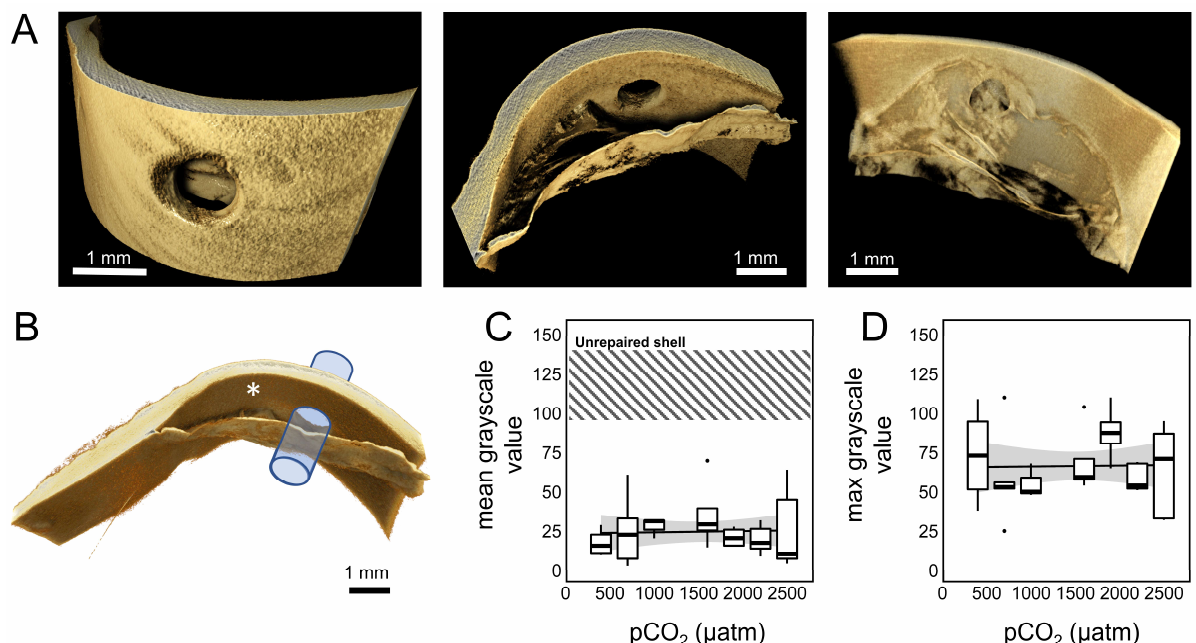
Figure 8. ( A ) The 3D rendering of a drill hole and deposited shell material constructed from µCT scan slices. Images represent three perspectives of the same shell repair from a single mussel ( M. trossulus ) held within the 400 µatm p CO 2 for 10 weeks. ( B ) Cylindrical volume used for analysis; asterisk marks approximate location used for control measurements of unrepaired shell. The mean ( C ) and maximum ( D ) grayscale values within sampled cylinders after 10 weeks within OA treatments ( n = 4–8 mussels per treatment).